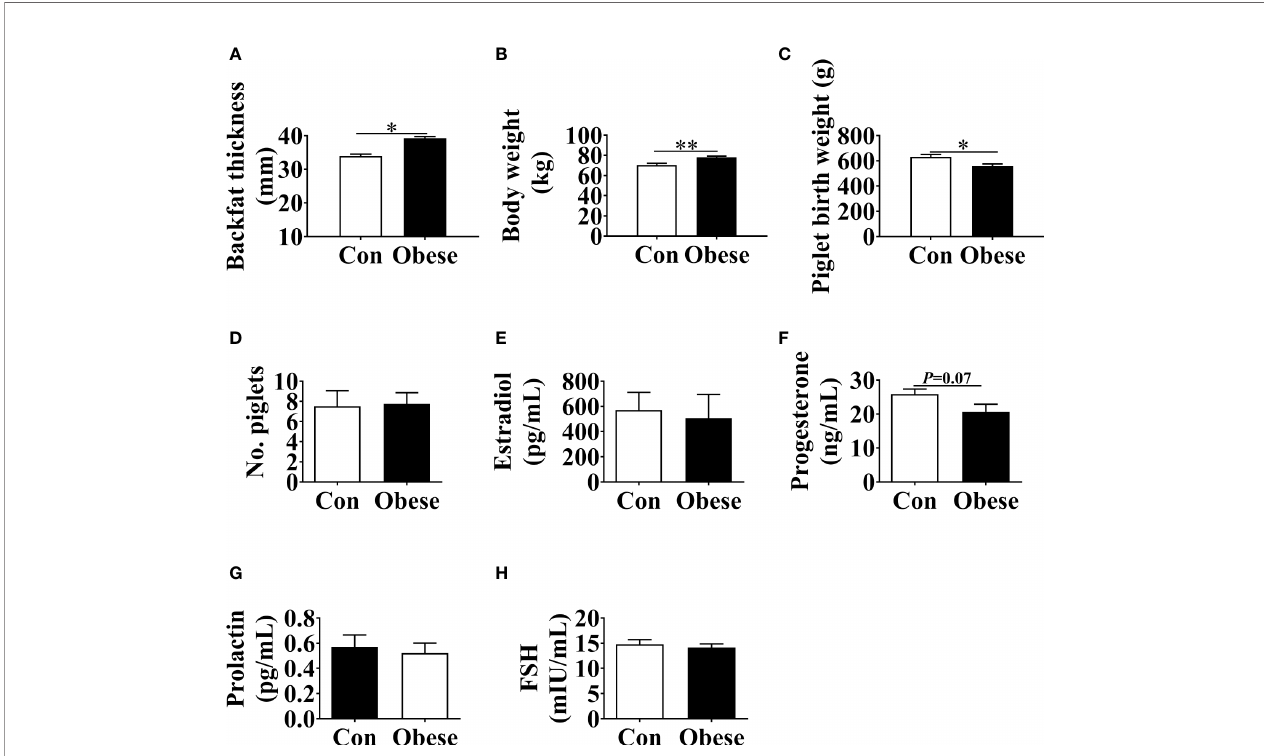
FIGURE 1 | Phenotype changes in gilts with different backfat thickness. Maternal backfat thickness (A) and body weight (B) at parturition day. (C) Piglet birth weight. (D) Number of piglets at birth. The concentrations of estradiol (E) , progesterone (F) , prolactin (G) , prolactin, and FSH (H) in maternal serum. Values are mean ± SEM, n = 10. “ * ” and “ ** ” indicate 0.01 < P ≤ 0.05 and 0.001 < P ≤ 0.01,